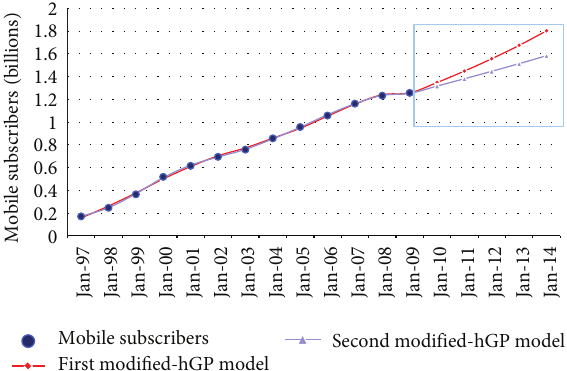
Figure 36: The forecasting performance (5 years ahead) of modified-hGP models—the pessimistic scenario. Figure 37: The forecasting performance (5 years ahead) of modified-hGP models—the moderate scenario.